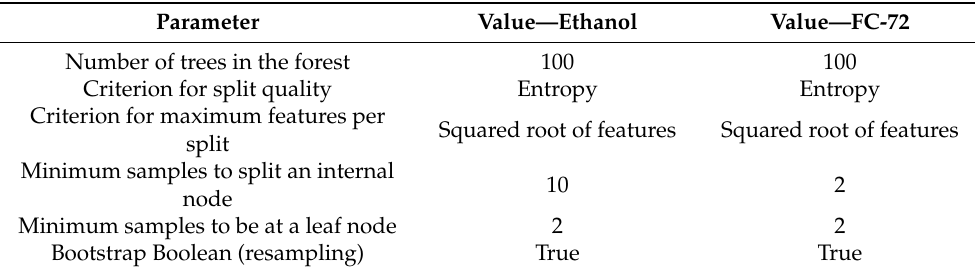
Table 7. Optimal hyperparameters for random forest